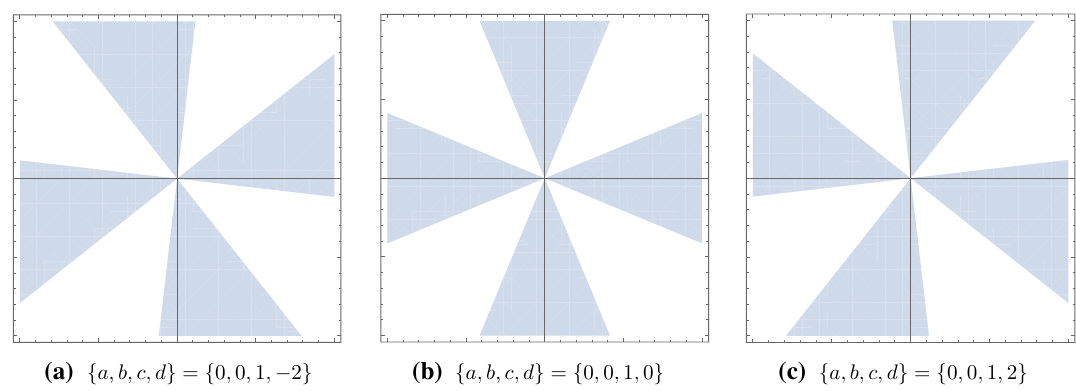
Fig. 1 A schematic representation of the regions of stability at infinity for the action given in Eq. (3.1). Inside the shaded regions, the integral in Eq. (2.2) is convergent. In general, the position and shape of these wedges are controlled by the parameters σ,λ and h in the